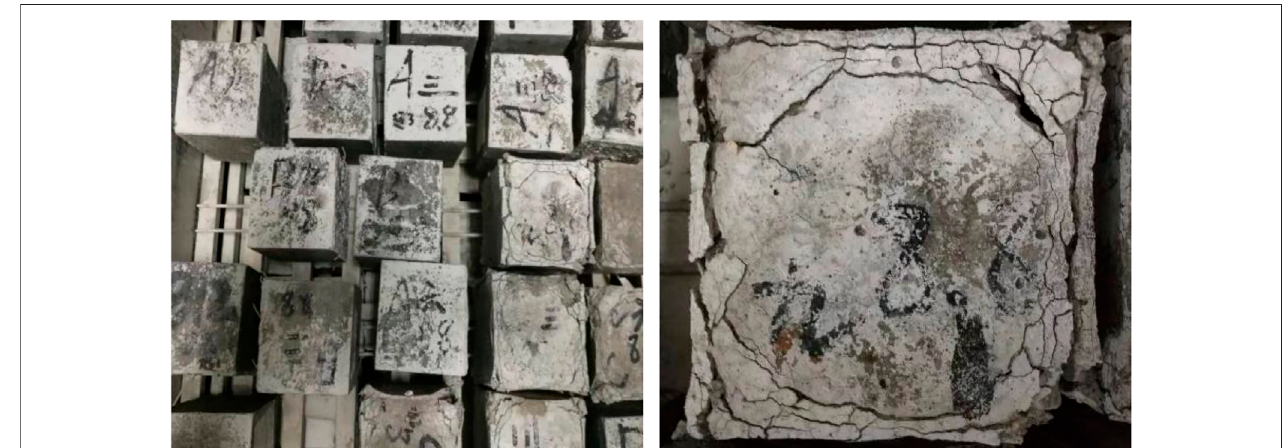
FIGURE 2 | Picture of concrete specimen damaged by sulfate wetting – drying